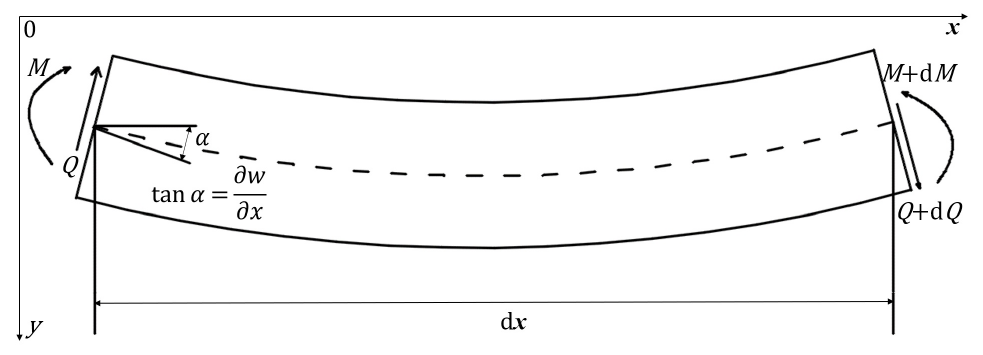
Figure 3. Schematic of basic equations using Euler–Bernoulli beam